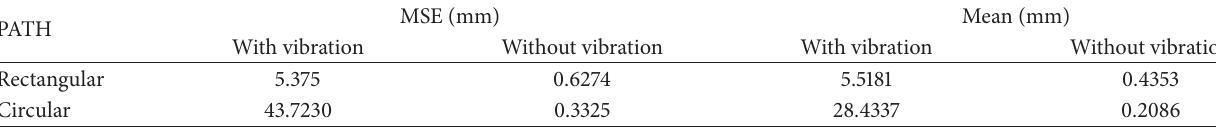
Table 6: Mean square error and mean of the error for robot path tracking.